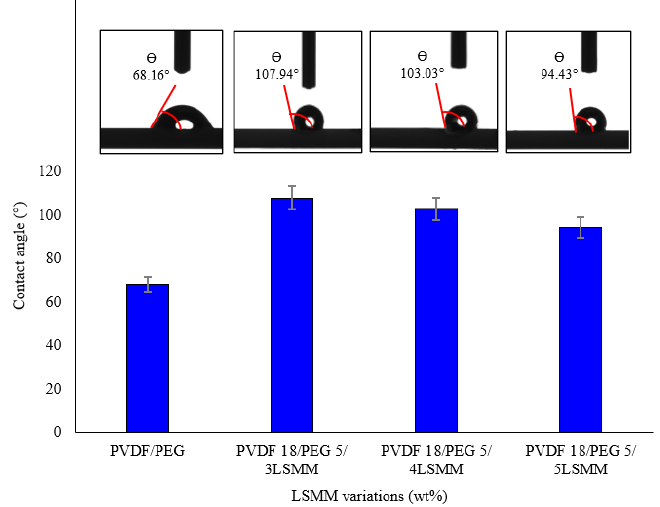
Figure 3. Water contact angle measurement result.